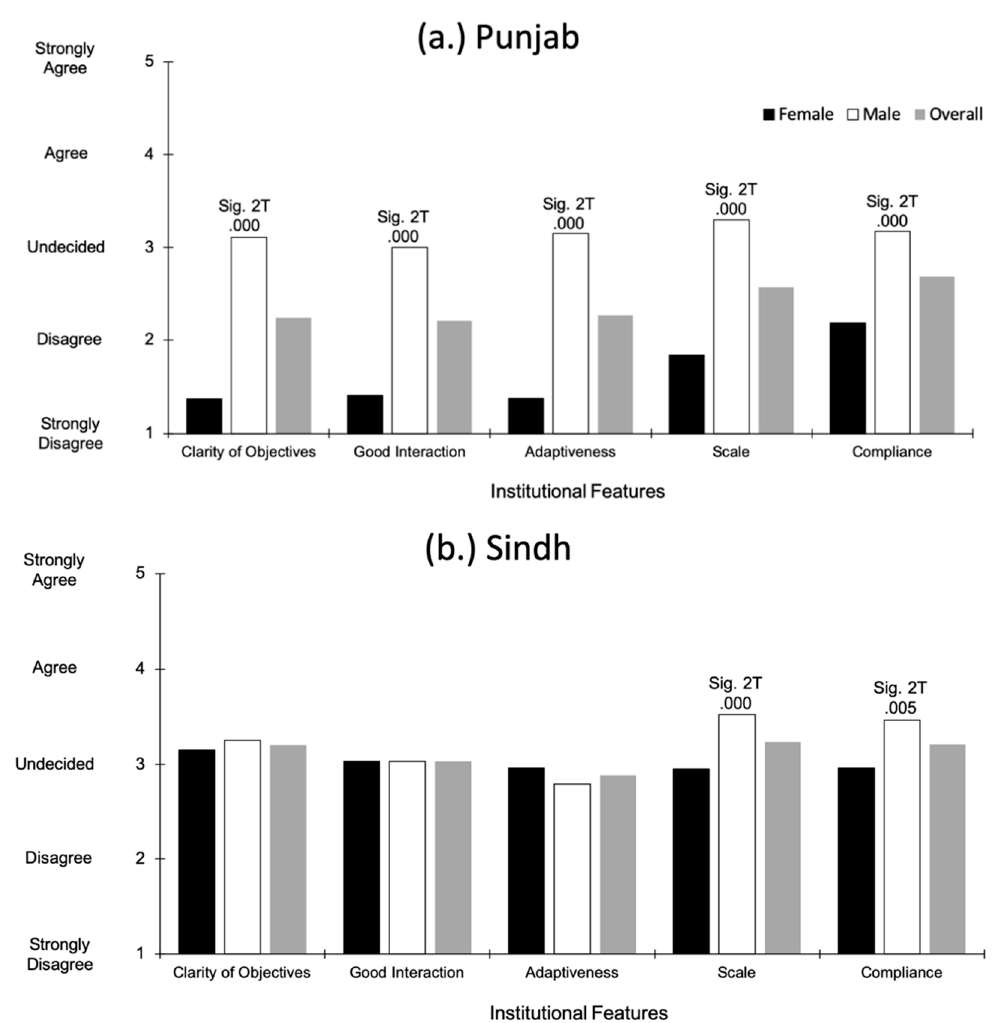
Figure 6. Comparative assessment of institutional features of PIM.